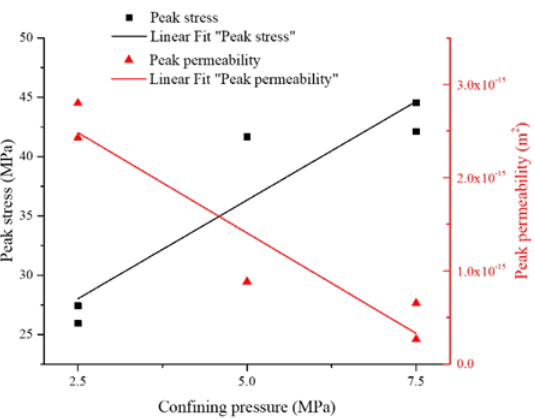
Figure 15. Peak differential stress and peak permeability versus confining pressure. Linear fitting for peak differential stress and peak permeability as function of confining pressure results in Equations (11) and (12), respectively (see Figure